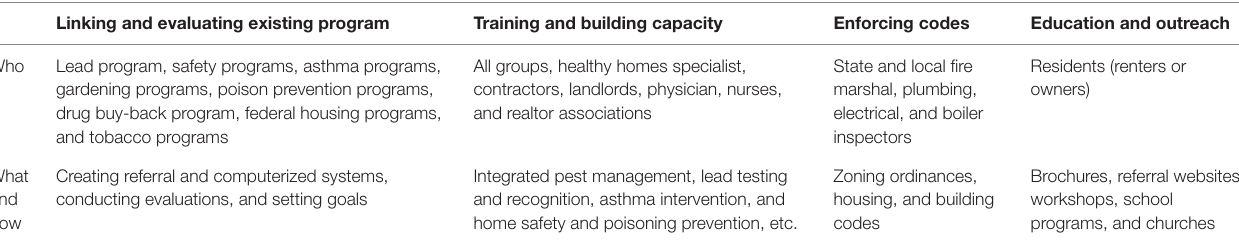
tABLe 2 | Dimensions of a healthy homes